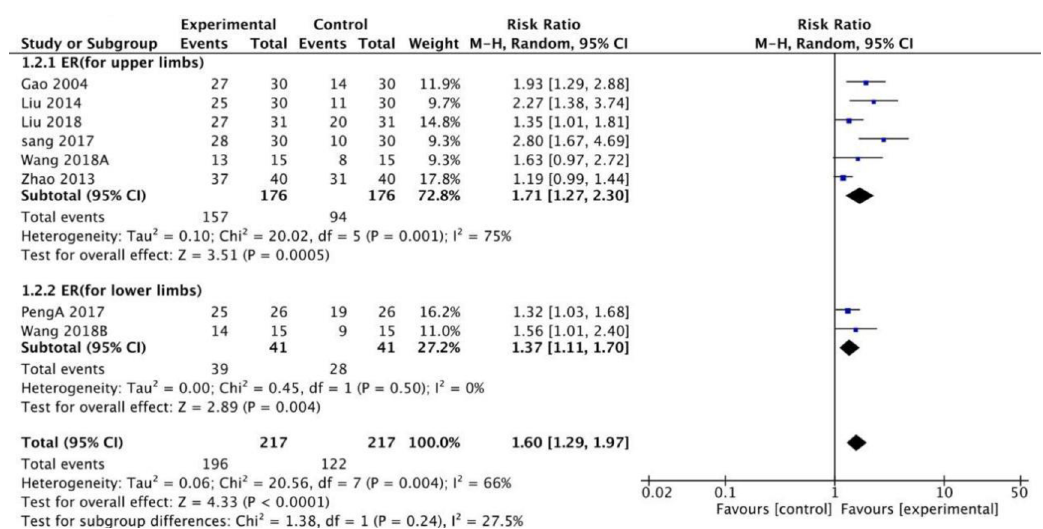
Fig 6. Meta-analysis of fire acupuncture versus acupuncture for spasticity after stoke.